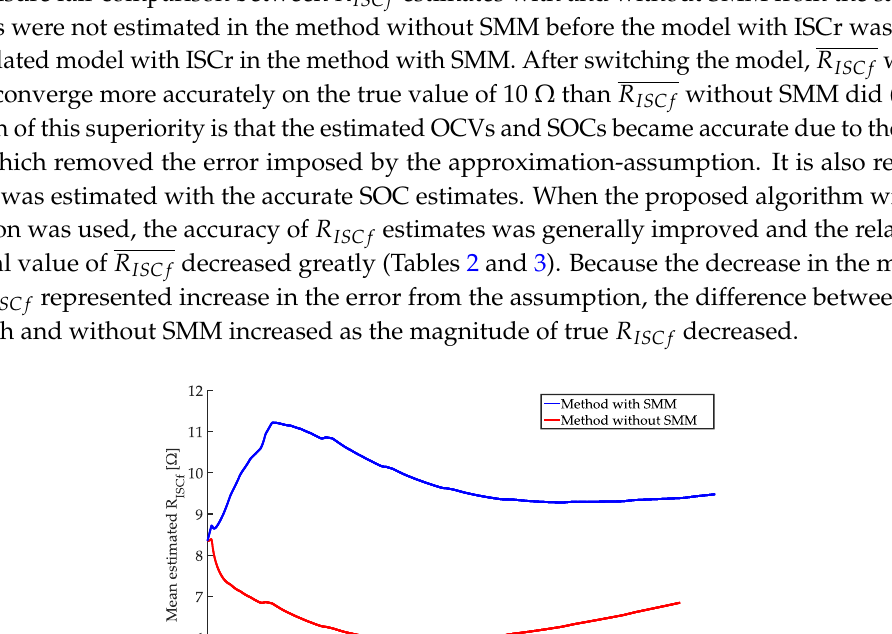
Figure 8. Comparison of 𝑅 𝐼𝑆𝐶𝑓 ̅̅̅̅̅̅̅ with and without SMM (experiment: cell A, DST 5 A and ISCr 10 Ω).